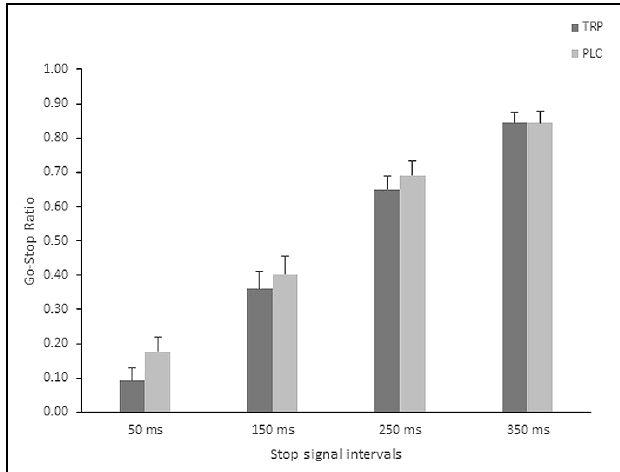
FIGURE 3 | Go-stop Ratio (stop signal task) following TRP Supplementation. (TRP, Tryptophan; PLC, Placebo). Error bars represent